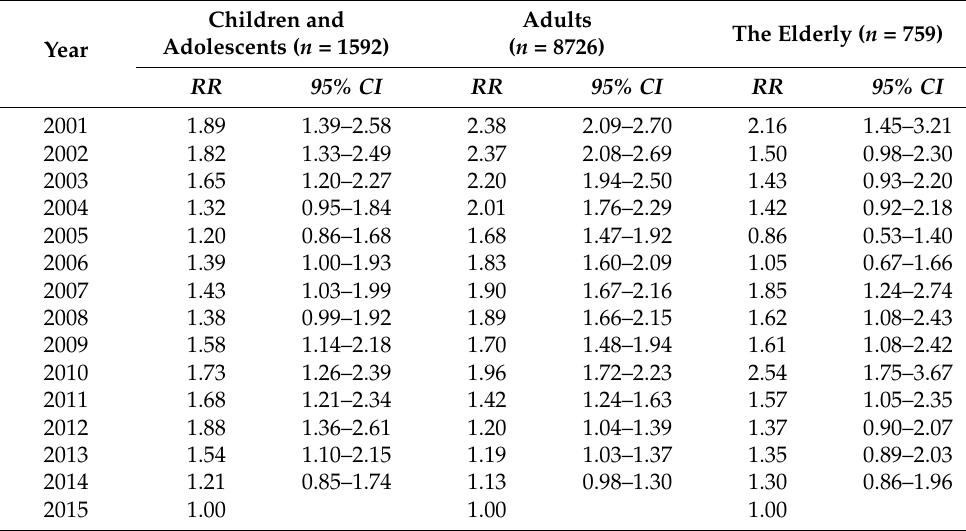
Table 3. Relative risk ratios (RR) of Children and Adolescents, Adults, and The Elderly who were subjected to violence to seek medical treatment over the